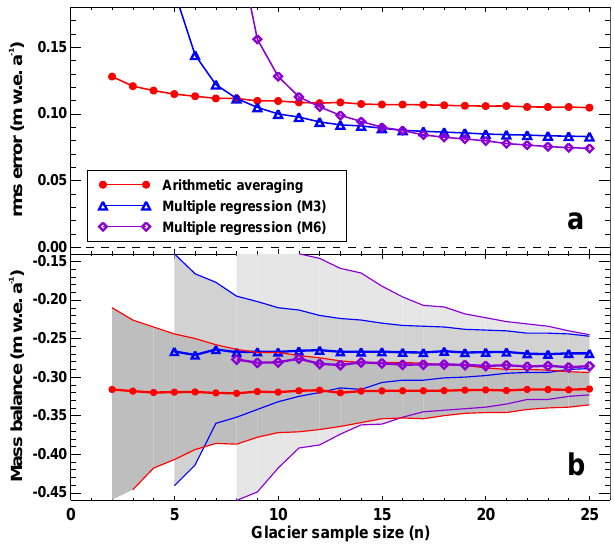
Fig. 7. Dependence of (a) the rms error and (b) the extrapolated mass balance for the European Alps (1908–2008) on glacier sam- ple size. Arithmetic averaging and multiple regression (M3, M6) are used for mass balance regionalization. All results are based on n = 1000 randomly drawn glacier samples and the 90% confidence interval for mountain-range mass balance is given by the shaded area in (b) . Lines with symbols show the median